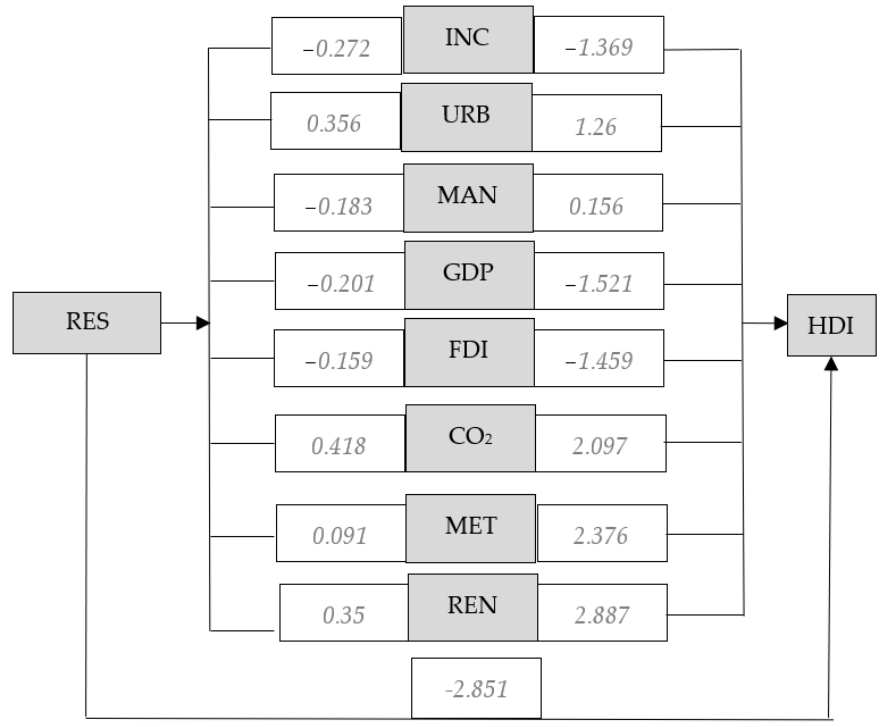
Figure A9. Role of the residential energy use per capita in explaining HDI of PCMS, 2018. Note: the insignificant values are marked with italics and grey.